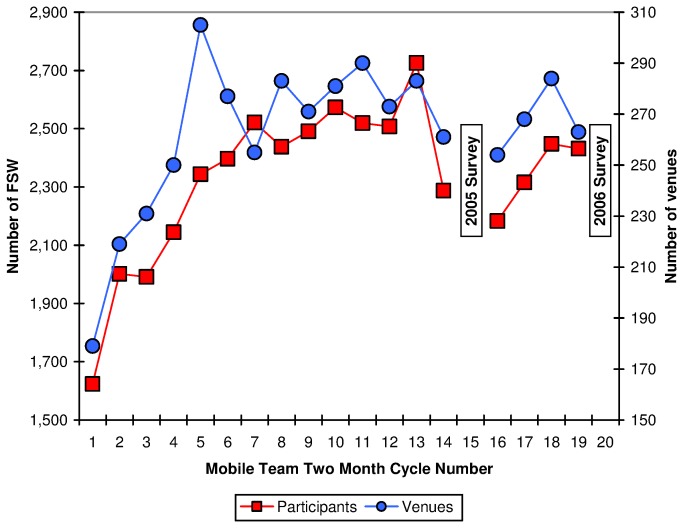
Numbers of female sex workers and commercial sex venues reached by Mobile Teams.The numbers of female sex workers and the numbers of commercial sex venues reached by mobile teams during the 20 eight-week intervention cycles is represented here. The numbers of sex work venues reached per cycle increased steadily from the first intervention cycle to the fifth cycle, then leveled off. Data from cycles 15 and 20 can’t be disaggregated from data for the 2005 and 2006 surveys of random samples of FSW in the ten cities, and therefore are not presented here.